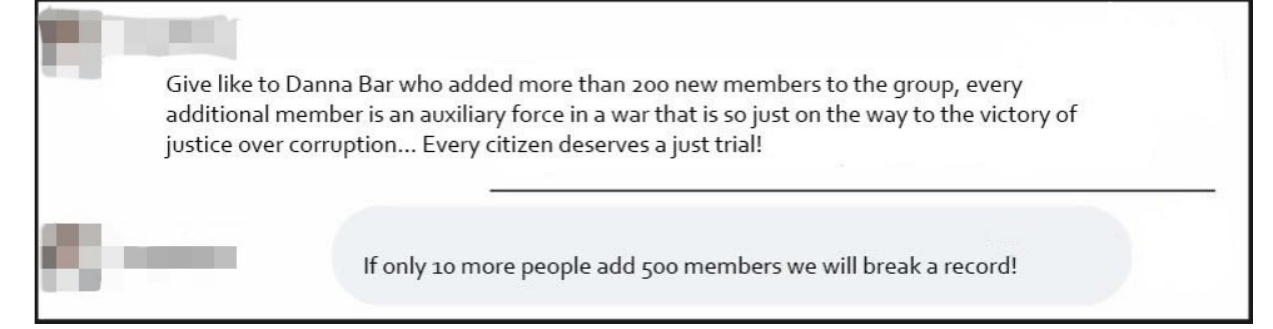
Figure 2. Adding